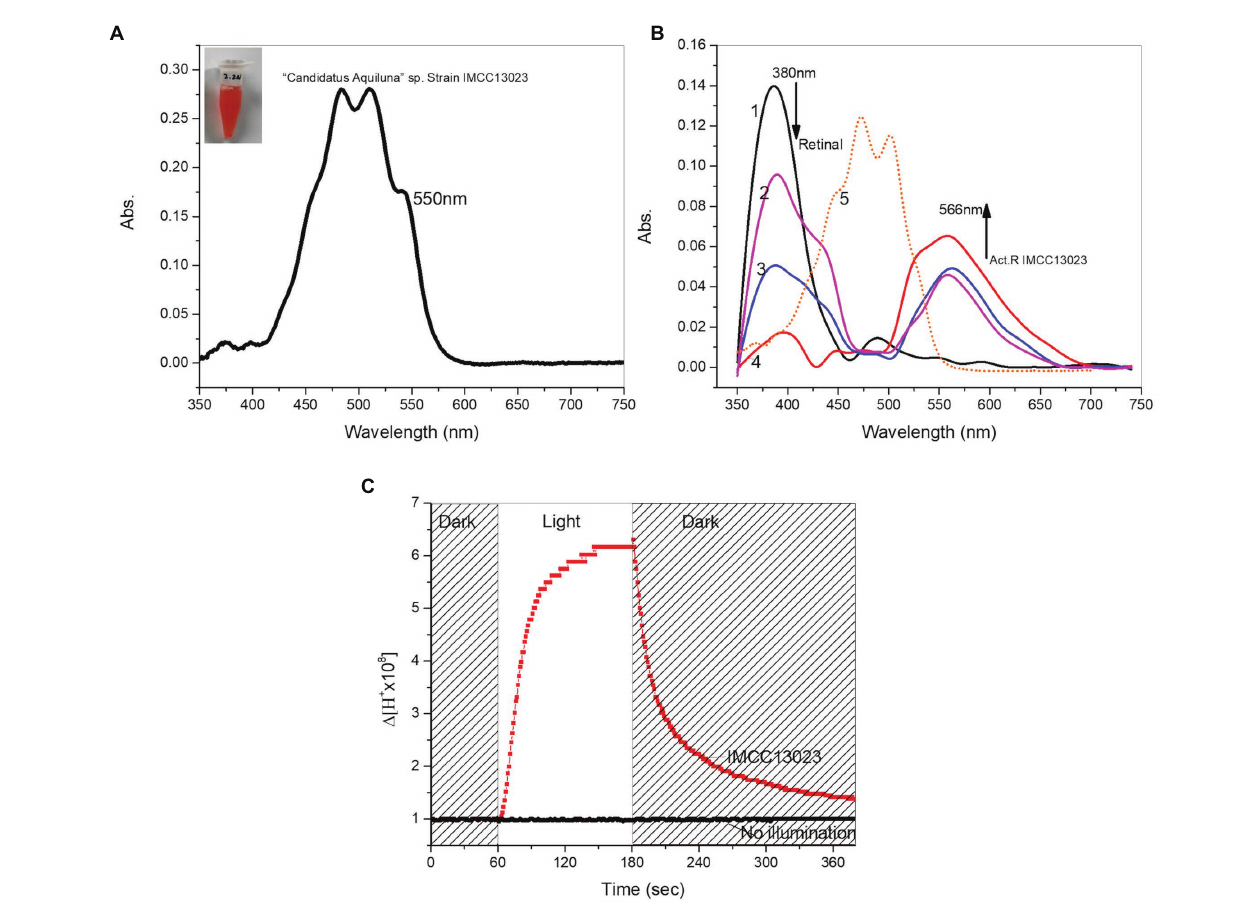
FIGURE 2 | Characterization of ActR-13023 in Candidatus aquiluna . (A) C. aquiluna whole-cell spectrum (black) and expected ActR-13023 peak in the native cell (red). (B) Chromophore removal from C. aquiluna membrane and reconstitution with all- trans -retinal (1) membrane fraction with chromophore removed, (2) 1 h, (3) 24 h, and (4) 48 h after reconstitution, (5) carotenoid isolated from C. aquiluna . (C) Measurement of proton pumping potential of C. aquiluna